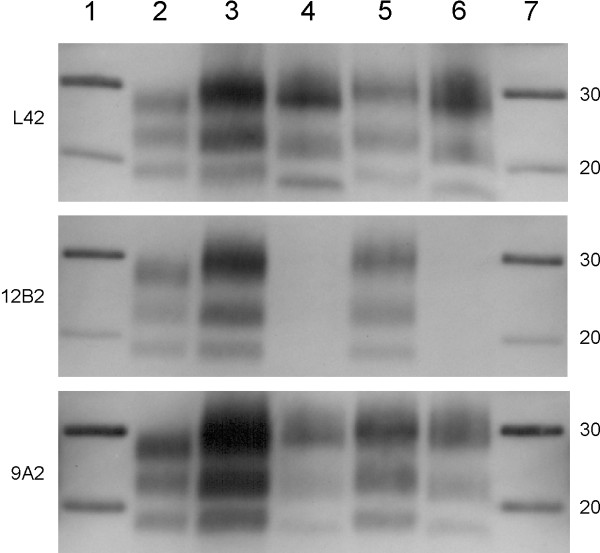
Typical PrPresprofiles in scrapie and BSE infected retropharyngeal lymph nodes using different antibodies. Type of specimen applied: lanes 1 and 7 molecular weight markers in kDa; lane 2 brain stem homogenate from ARQ/VRQ sheep with scrapie; lane 3, RLN from VRQ/VRQ scrapie sheep at age 26 m; lane 4, RLN from BSE-infected ARQ/ARQ sheep in preclinical stage of disease; lane 5, RLN from ARQ/ARQ sheep with subclinical (brain positive, no clinical signs) stage of scrapie; lane 6, RLN from BSE-infected ARQ/ARQ sheep in clinical stage of disease. Amounts of tissue applied: lane 2, 200 μg TE, lanes 3–6, 10 mg TE. Antibody concentrations used: L42 and 12B2, 0.2 μg/ml; 9A2, 2 μg/ml.